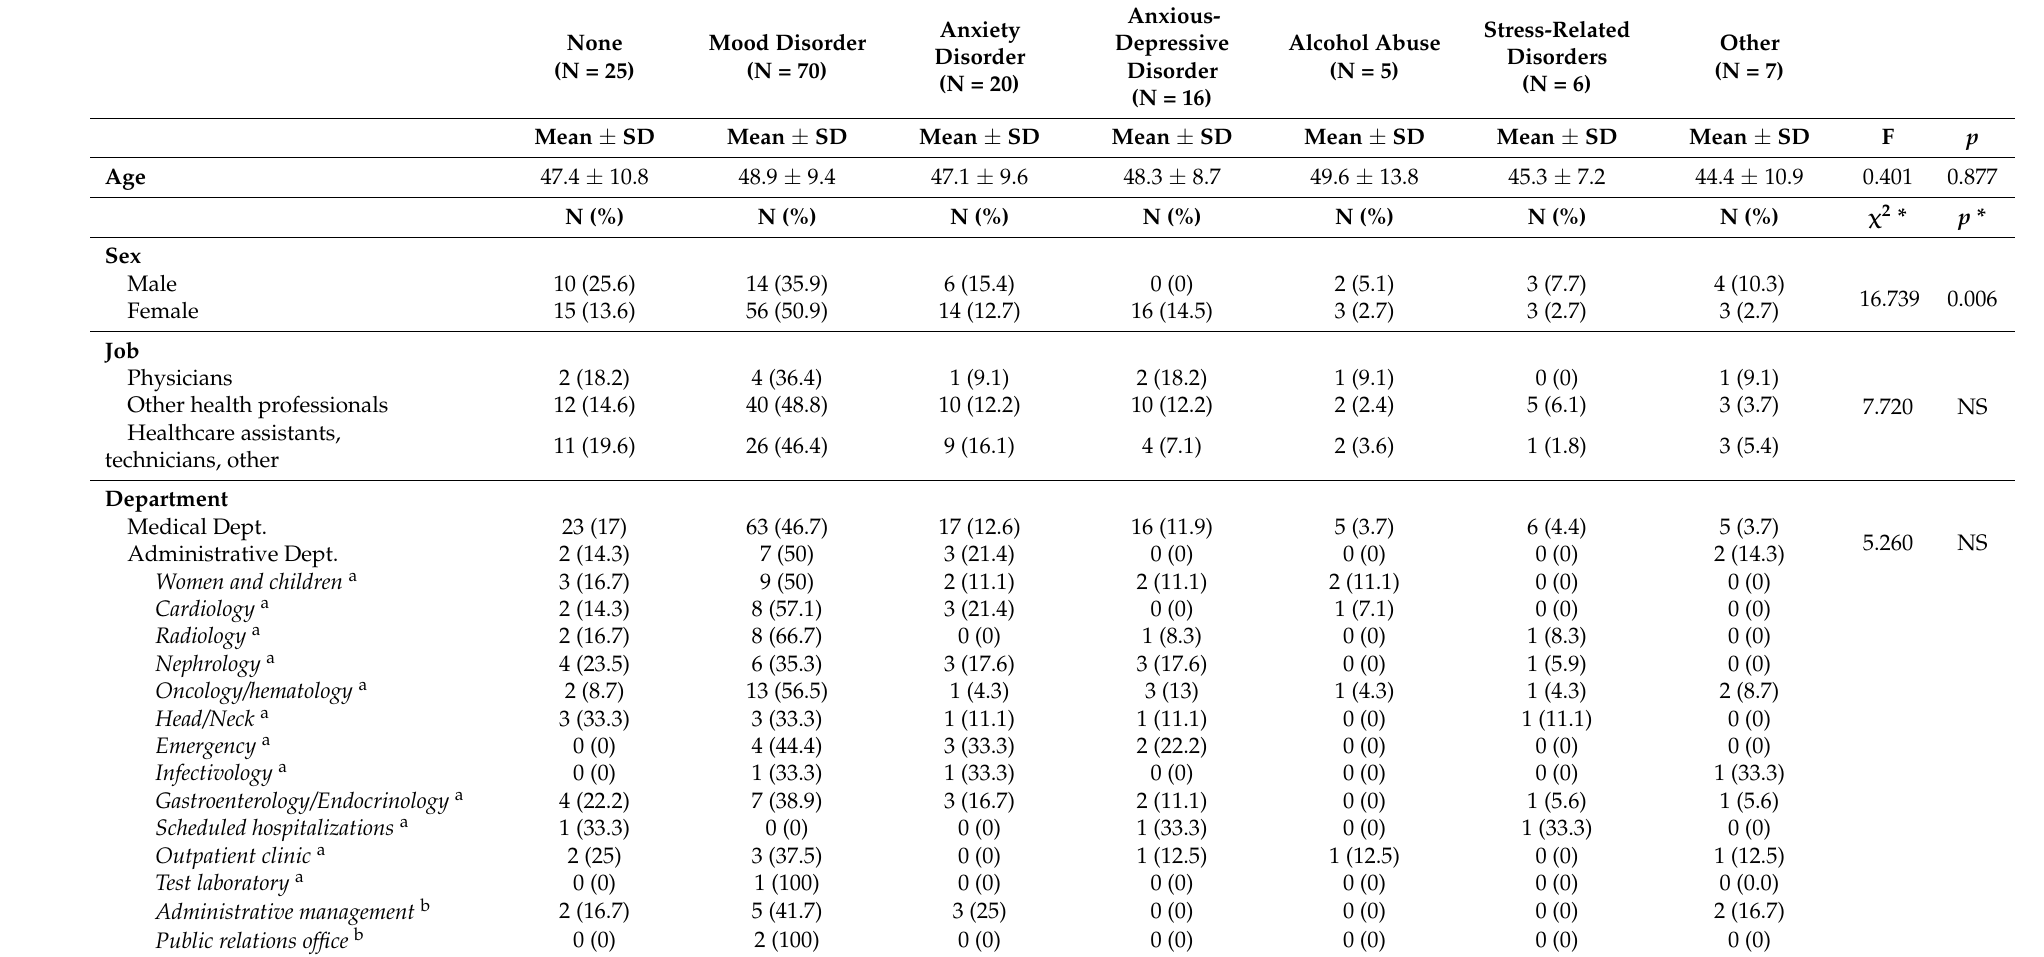
Table 2. Associations between psychiatric diagnoses and age, sex, job, department, and